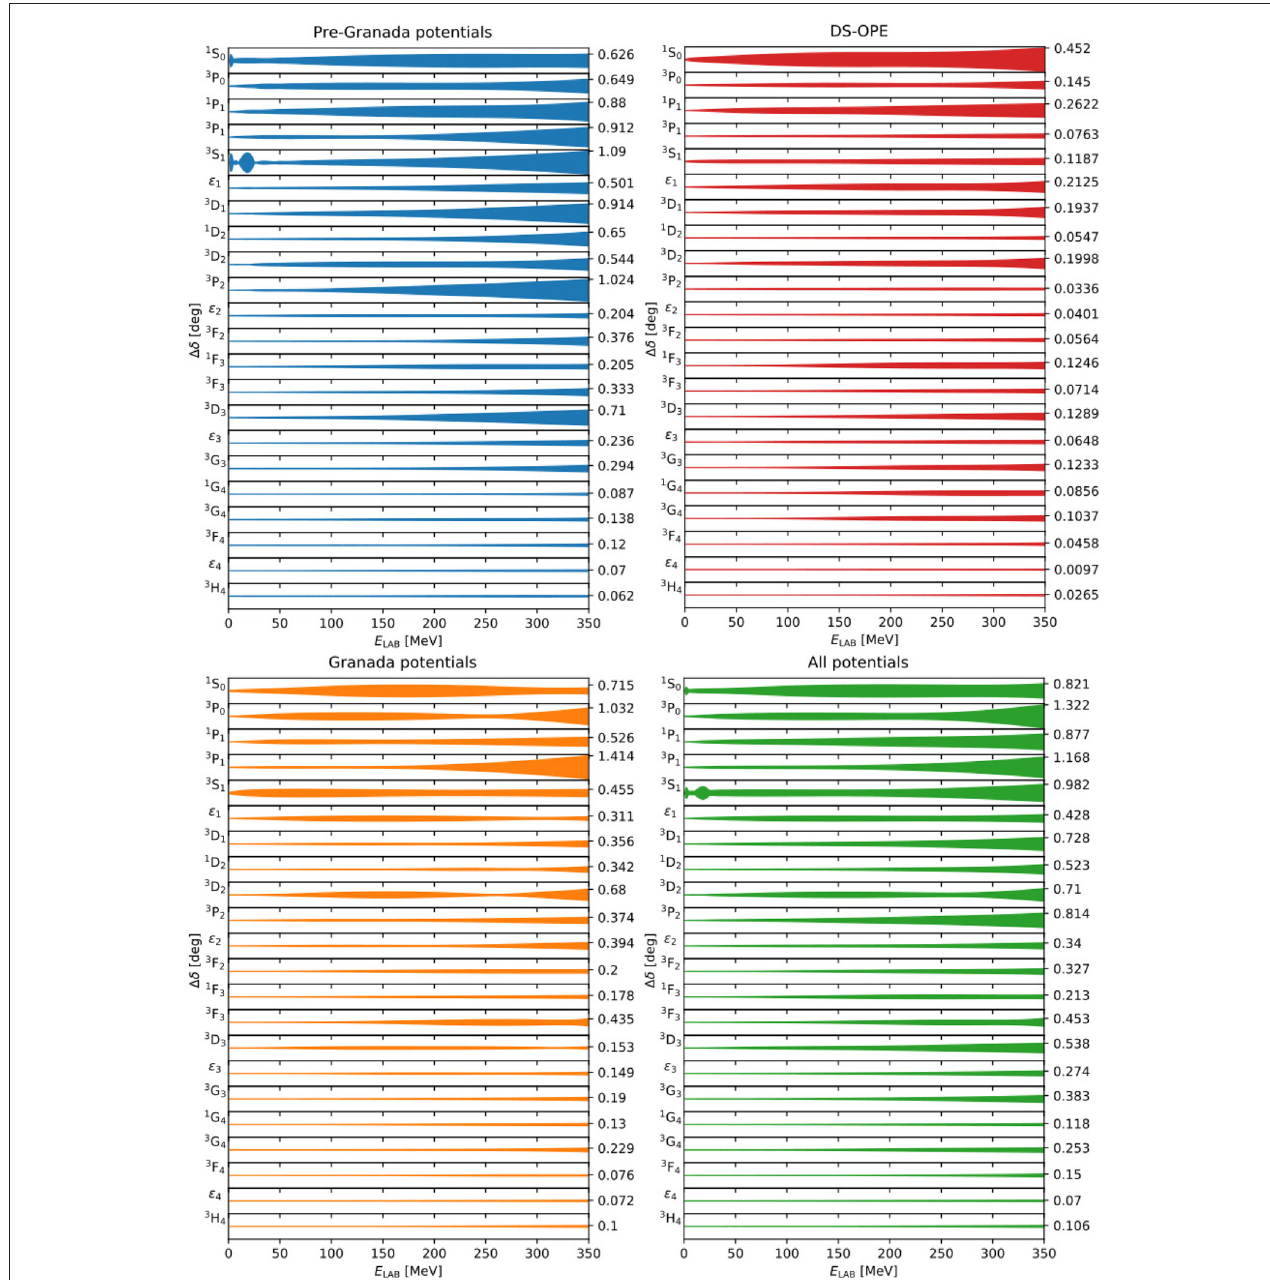
FIGURE 2 | Uncertainties (in degrees, right axis) for partial wave np phase shifts with J function of the LAB energy (in MeV). (Upper left) Averaged errors for pre-Granada potentials [15–19]. (Upper right) Statistical errors for the primary Granada 2013 χ 2 analysis [45]. (Lower left) The averaged errors for the 6 Granada potentials [45, 75, 77]. (Lower right) Averaged errors for all 13=7 pre-Granada and the 6 Granada